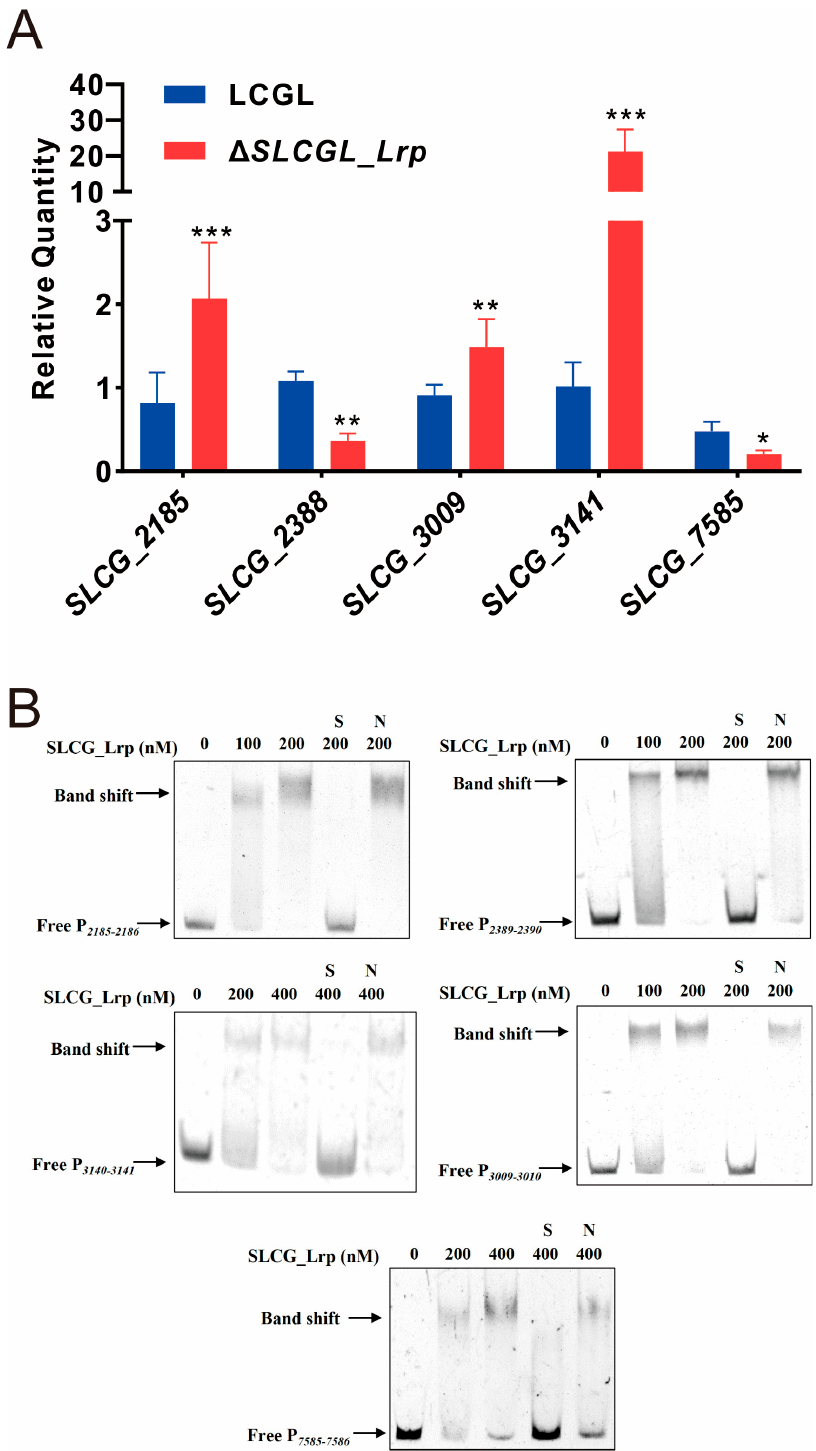
Figure 5. SLCG_Lrp directly regulates the transcription of five regulatory genes in S. lincolnensis . ( A ) RT-qPCR analysis of five regulatory genes in LCGL and ∆ SLCGL_Lrp . ( B ) EMSA analysis of SLCG_Lrp and promoter regions of five regulatory genes. S: unlabeled specific probe (20-fold); N: nonspecific probe poly dIdC (20-fold). The mean values of three replicates are shown, with the standard deviations indicated by error bars. * p < 0.05, ** p < 0.01, *** p <